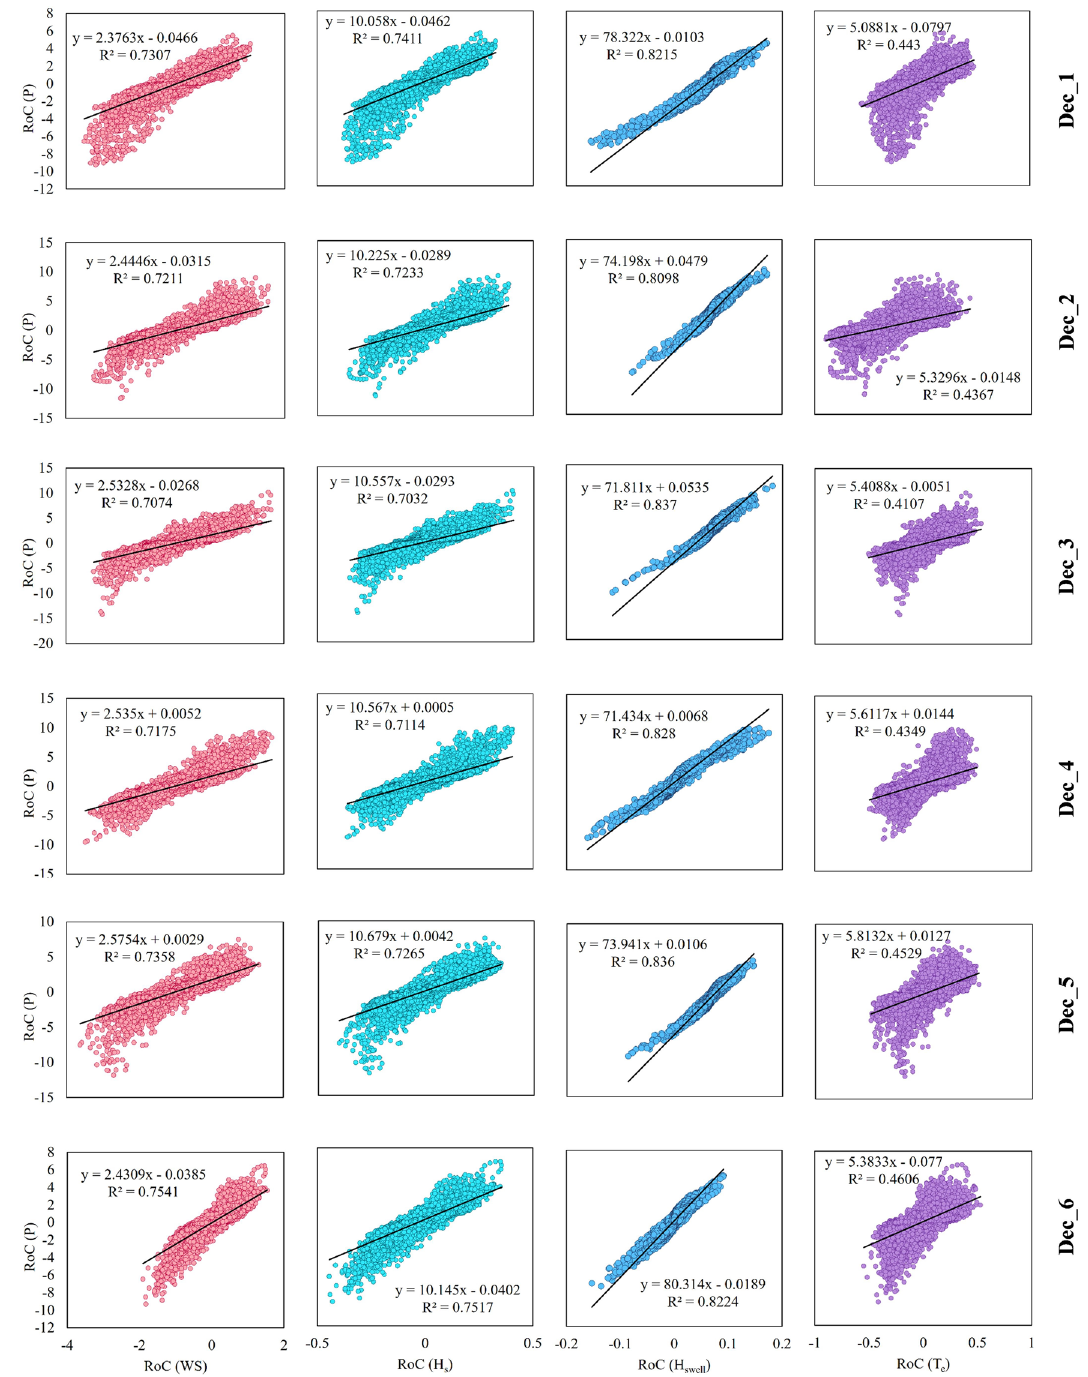
Figure 4. Rows from top to bottom show Dec_1 to Dec_6, and columns from left to right show linear regression between the rate of change of P and WS, H s , H swell, and T e , respectively. The vertical axis shows the rate of change (RoC) of P, whereas the horizontal axis shows the RoC for other wave